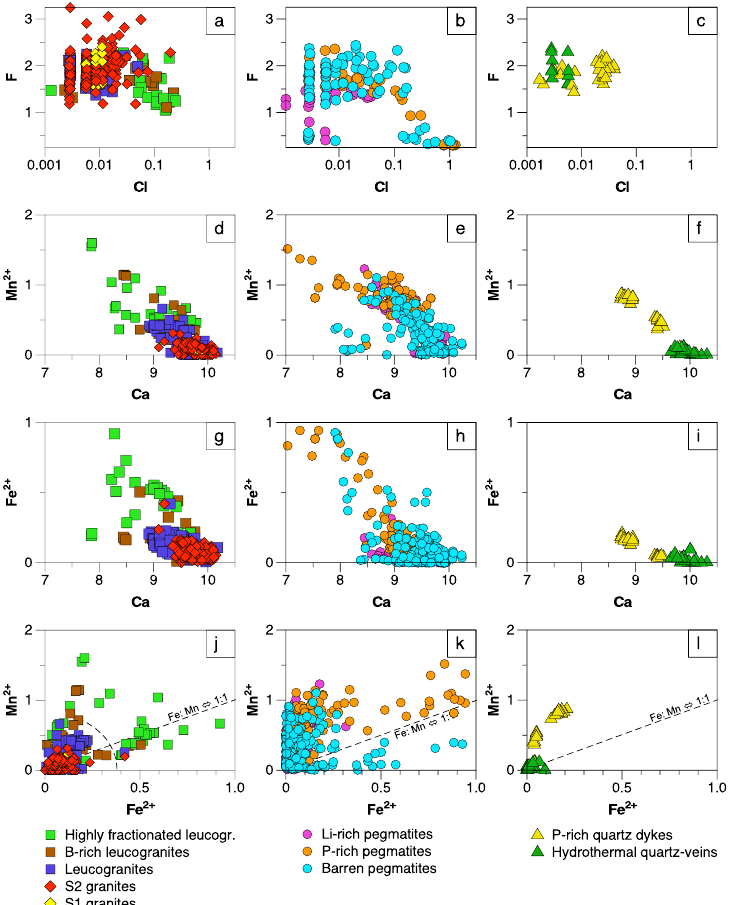
Figure 3. Binary plots of the major and main minor elements for apatite from the different lithologies (all the values in a.p.f.u): ( a – c ) Cl versus F; ( d – f ) Ca versus Mn; ( g – i ) Ca versus Fe; and, ( j – l ) Fe versus Mn; in all the cases for granitic, pegmatitic and hydrothermal veins, respectively.